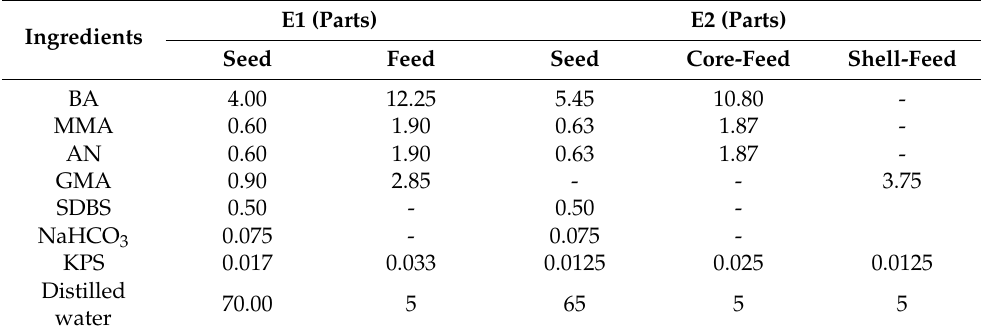
Table 1. The composition of acrylic